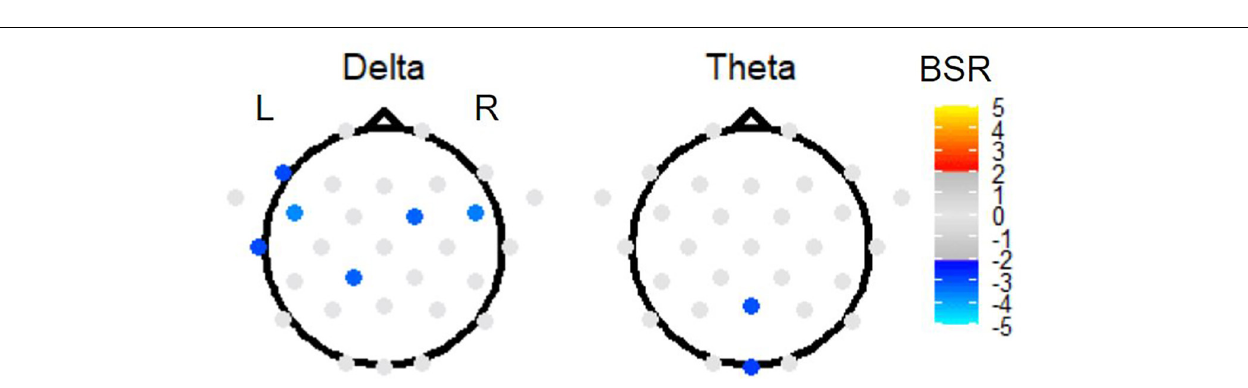
FIGURE 7 | The BSRs of the first latent variable in the Link B vs. Link A task PLS subtest. All electrode BSRs were FDR-corrected and thresholded as described in the text. The electrode spatial patterns in alpha, beta, and gamma bands were not